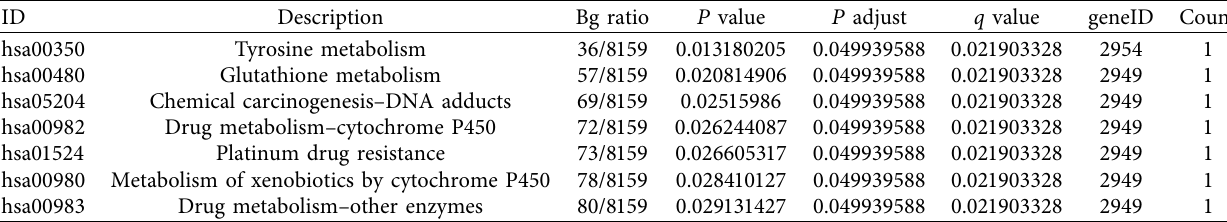
Figure 10: Enrichment analysis and coexpression analysis of important DEGs: (a) GO enrichment analysis of 7 important DEGs; (b) KEGG enrichment analysis of 7 important DEGs; (c) analysis of important DEGs and their interacting genes by GeneMANIA; (d) GO enrichment analysis of 25 interacting genes; (e) KEGG enrichment analysis of 25 interacting genes. Table 6: KEGG enrichment results of important